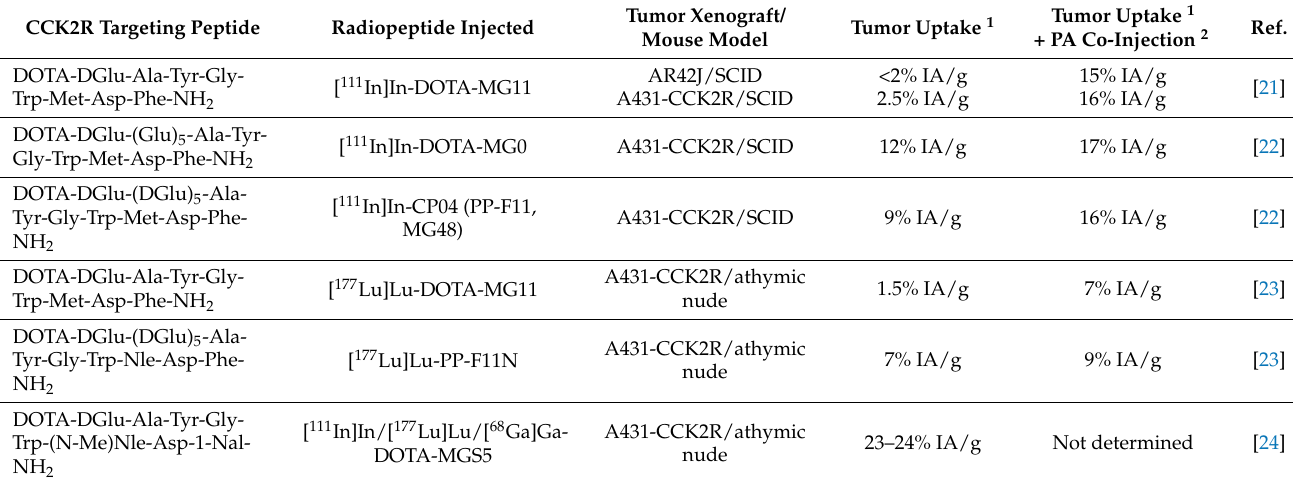
Table 1. Tumor targeting properties of selected radiolabeled CCK2R targeting peptide analogs. CCK2R Targeting Peptide